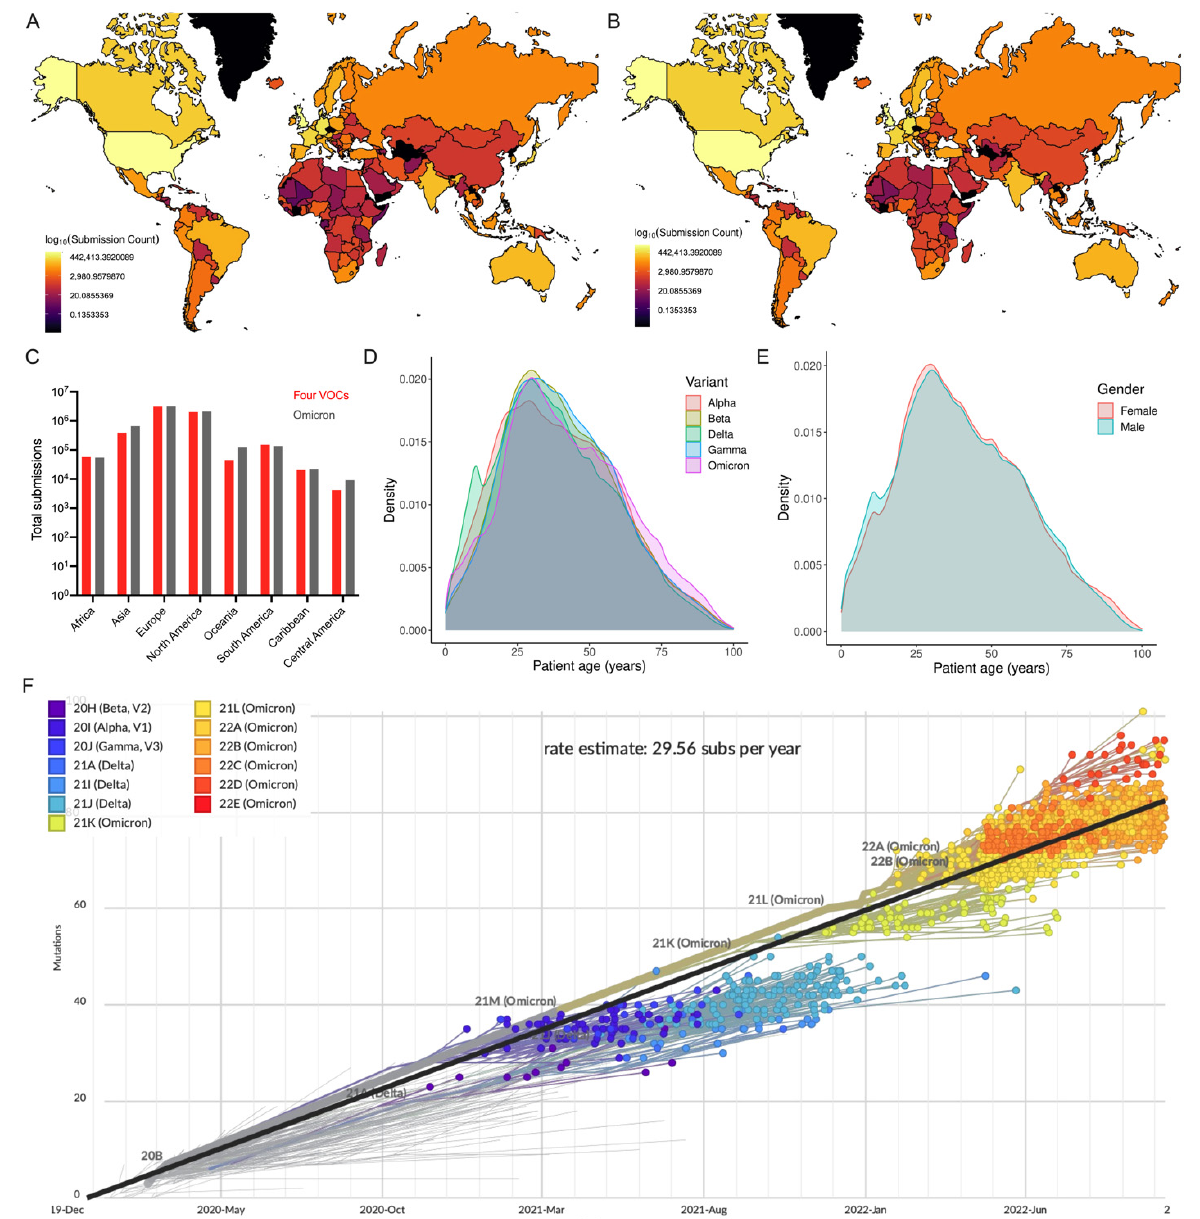
Figure 1. Global distribution of SARS-CoV-2 VOCs as reported in GISAID. ( A ) Number of Omicron and ( B ) all VOC genome sequences reported in GISAID. ( C ) Number of four VOCs and Omicron genome sequences (continent-wise) are presented. ( D ) Density plot shows the probability density distribution of five VOC genomic sequences based on age of COVID-19 cases. Only 38% (4.55 million) of the VOC sequences described the patient’s age (0–100 years) were considered. ( E ) Density plot displays the distribution of the consolidated number of all five VOC genomic sequences based on gender. ( F ) Phylogenetic tree based on a subset of globally circulating VOCs sequences created by Nextstrain (accessed on 22 October 2022).